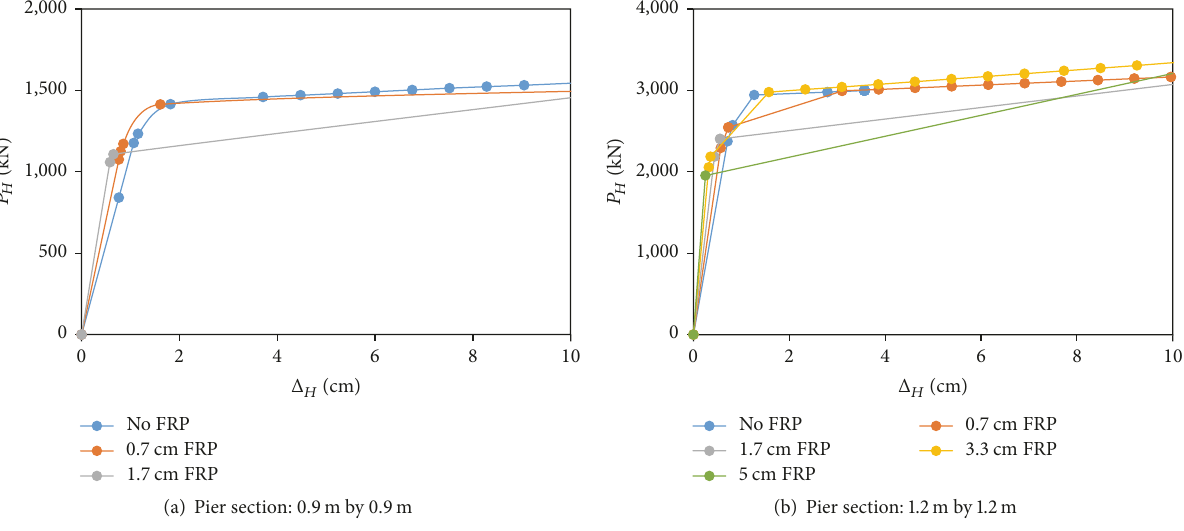
Figure 11: Wide pier system with 𝑊 = 9 m and 𝐻 = 6m ( 𝑓 󸀠 𝑐 =